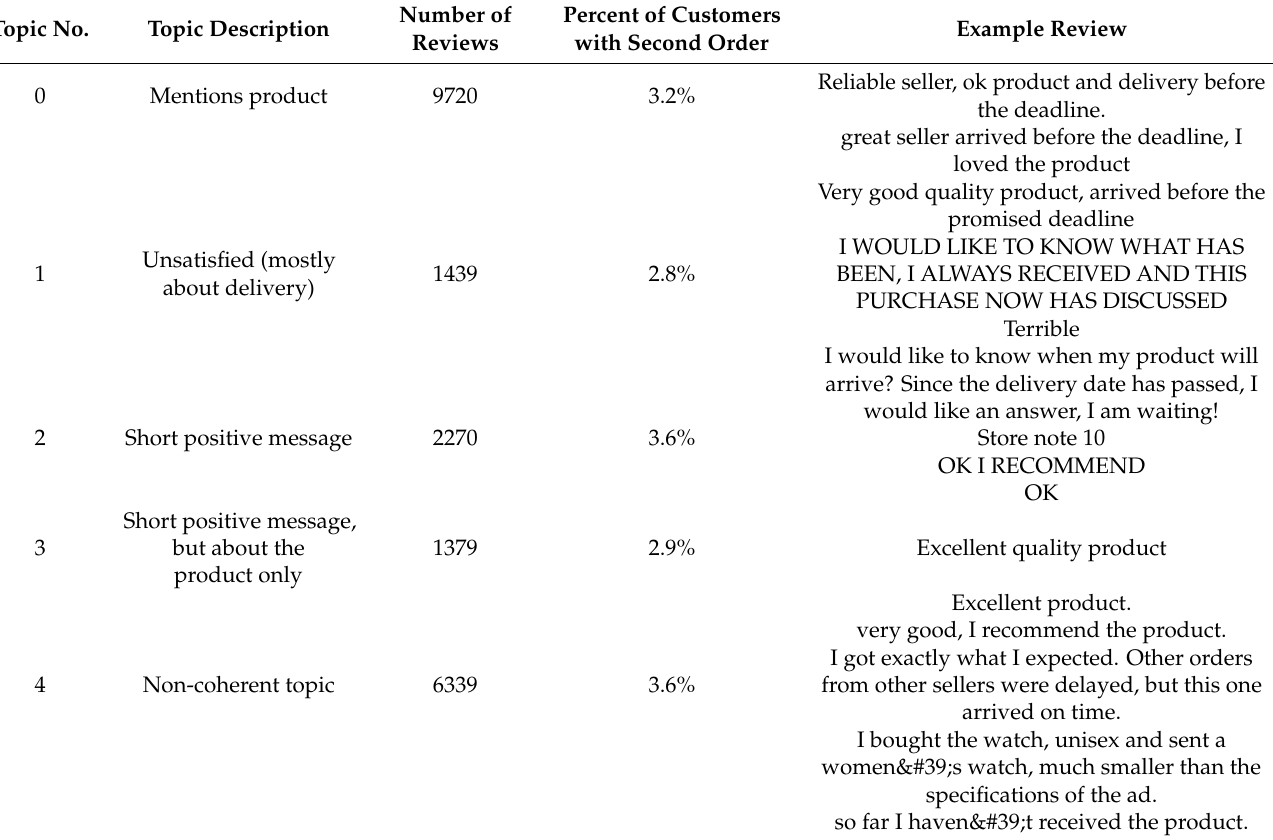
Table A1. Topics inferred by attention-based aspect extraction.